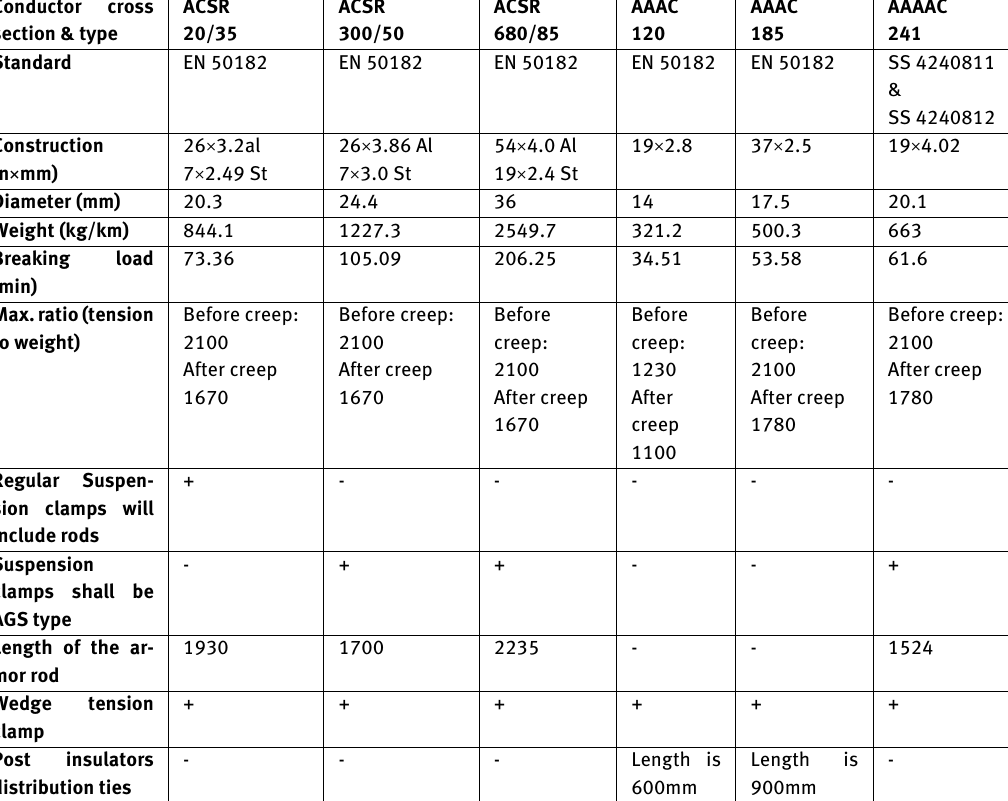
Table 1: High performance conductors and its specifications